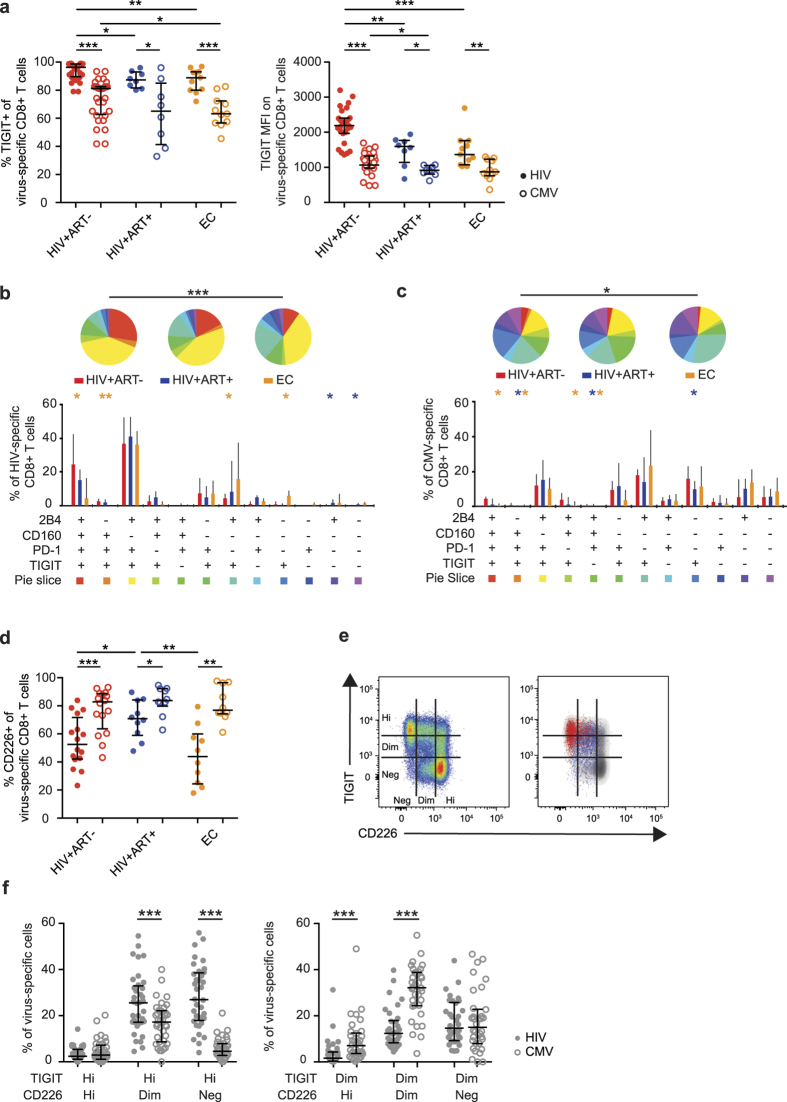
Linkage between TIGIT and CD226 expression on HIV-specific and CMV-specific CD8+ T cells.(a) Frequency and mean fluorescence intensity of TIGIT on HIV-specific (filled circles) and CMV-specific (open circles) CD8+ T cells in HIV-positive treatment-naive (HIV+ART−, red, n = 27), long-term treated (HIV+ART+, blue, n = 8) and elite controller (EC, orange, n = 11) subjects. (b,c) SPICE analysis of inhibitory receptor co-expression on HIV-specific CD8+ T cells (b) and CMV-specific CD8+ T cells (c) in HIV+ART− (n = 27), HIV+ART+ (n = 8) and EC (n = 11) subjects. (d) Frequency of CD226+ cells of HIV-specific (filled circles) and CMV-specific (open circles) CD8+ T cells in HIV+ART− (n = 15), HIV+ART+ (n = 10) and EC (n = 10) subjects. (e) Gating strategy for TIGIT hi/dim/neg and CD226 hi/dim/neg on total CD8+ T cells and an overlay of HIV-specific (red) and CMV-specific (blue) cells from a representative treatment naïve HIV infected subject. (f) Frequency of TIGIThi and TIGITdim HIV-specific (closed circles) and CMV-specific (open circles) CD8+ T cells that are CD226hi, CD226dim and CD226neg in chronically HIV infected subjects (n = 46). The Wilcoxon matched-pairs signed rank test was used to compare paired samples. The Mann-Whitney test was used to compare two groups. Permutation test was performed between the pie charts. Median and IQR are shown for all bars. *P < 0.05, **P < 0.01 and ***P < 0.001.